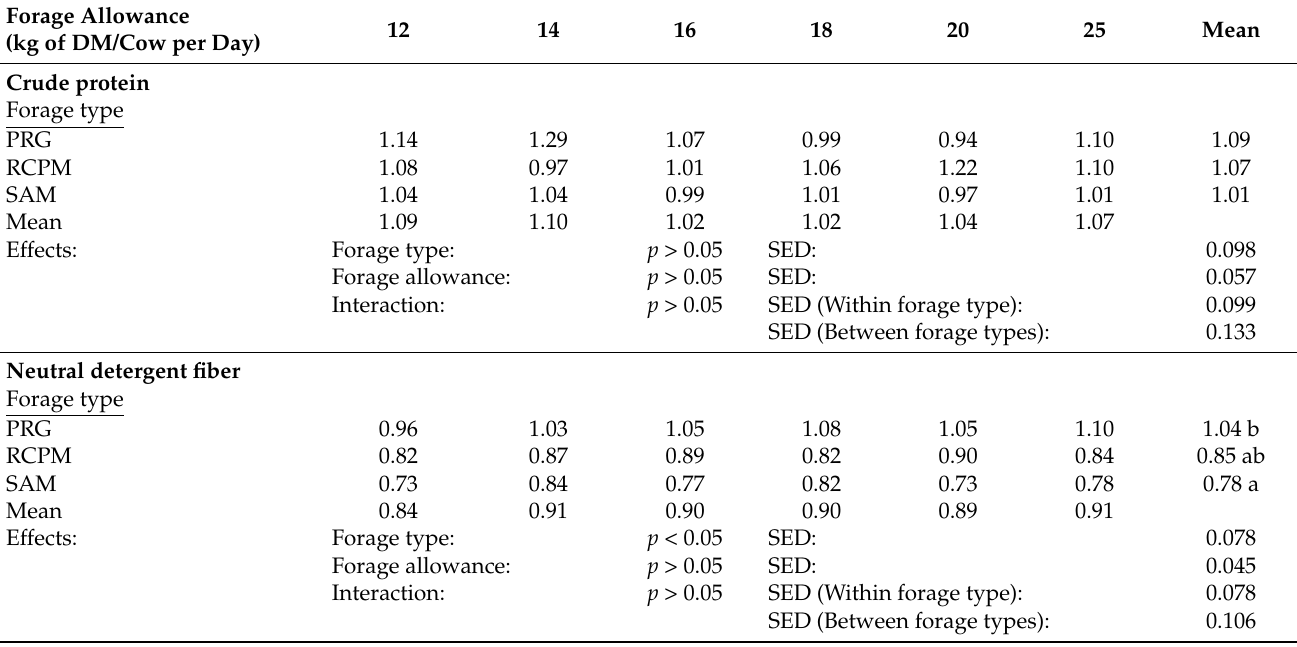
Table 6. Selection differentials for crude protein, neutral detergent fibre and acid detergent fibre by early lactation dairy cows grazing three forage types at six forage allowances. Forage types included PRG, perennial ryegrass monoculture; RCPM, perennial ryegrass, white clover and plantain mixture; and SAM, spatially adjacent monocultures of perennial ryegrass, white clover and plantain. Values with different scripts are significantly different ( p < 0.05). At the interaction level, values with different upper-case scripts differ within a forage allowance, while values with different lower-case scripts differ within a forage